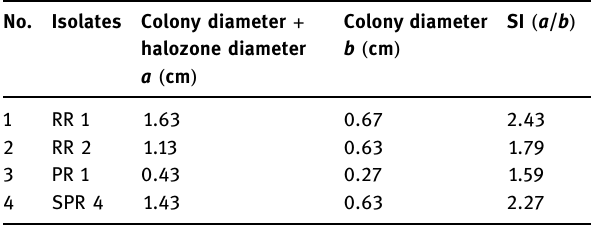
Table 1: Selected four PSB isolates from rice rhizosphere ( RR 1